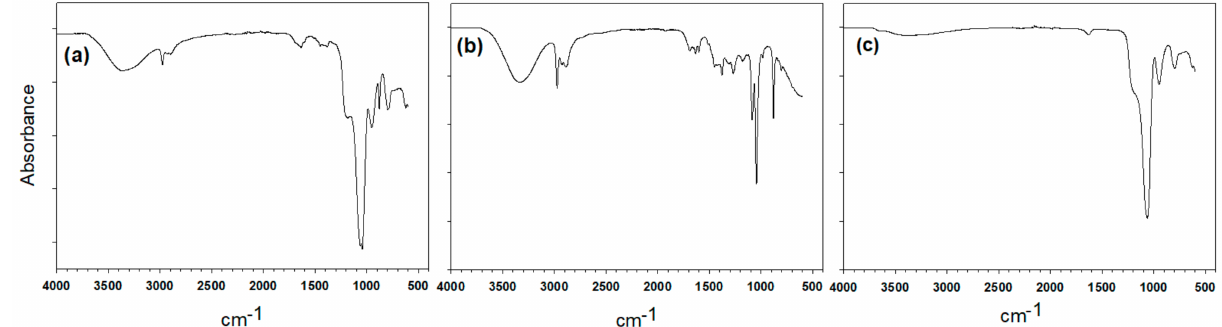
Figure 1. ATR-FTIR spectra of propolis-embedded zeolite nanocomposites ( a ), free propolis ( b ) and zeolite ( c ).